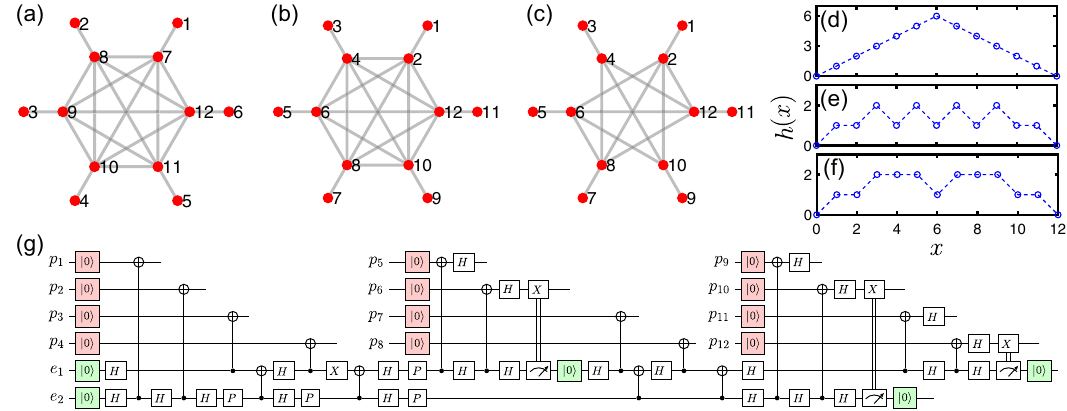
Fig. 2 Results for repeater graph states. a 12-photon repeater graph state in which external photons are emitted fi rst. b Same graph state as in ( a ), but with “ natural" emission ordering. c Same graph state as in ( b ) but with some unnecessary edges deleted. ( d ), ( e ) and ( f ) show the height functions of the states in ( a ), ( b ), and ( c ), respectively. g Emission circuit for state shown in ( c ), where H is the Hadamard gate, P = diag (1, i ) is the phase gate, and X ≡ σ x .